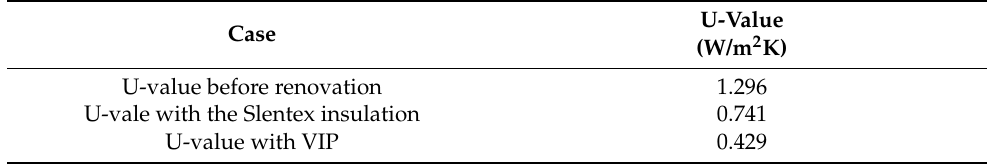
Table 4. The overall heat transfer coefficients.